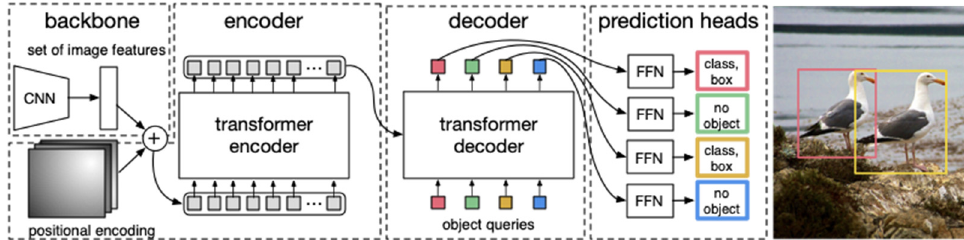
Figure 6. The network structure of the DETR [36].